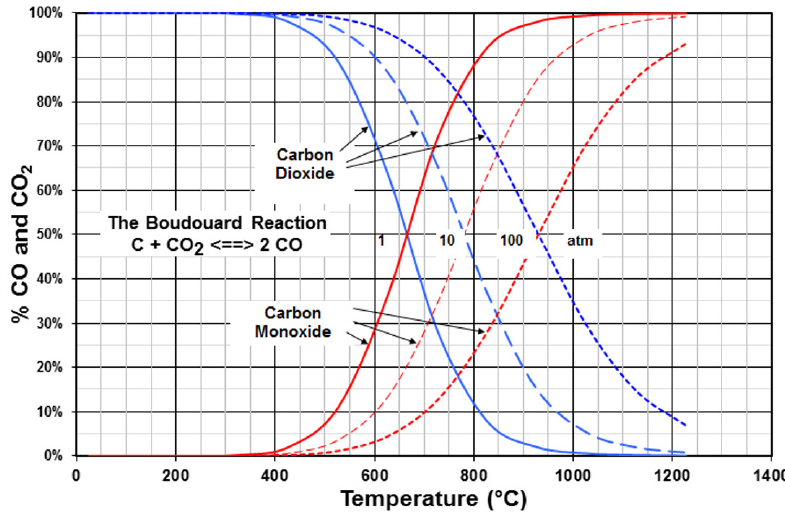
Figure 9. Equilibrium of the Boudoard reaction at different temperatures.